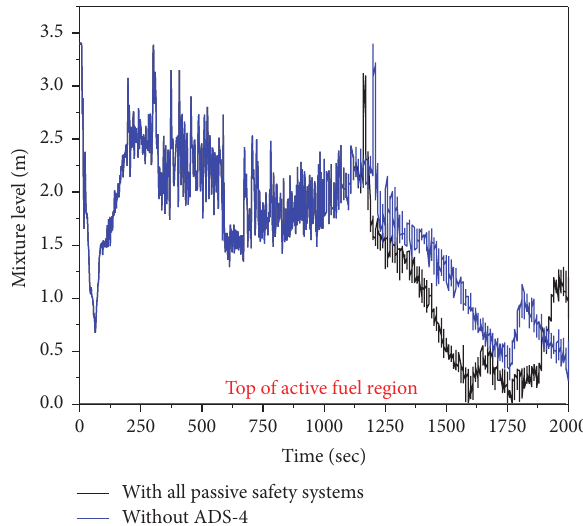
Figure 17: Comparison mixture level above core active region in case-1 and